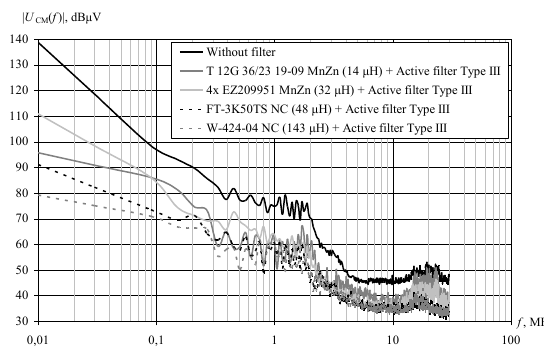
Fig. 2. Obtained CM EMI spectra generated by a frequency inverter without a filter and with a hybrid filters with various core materials .